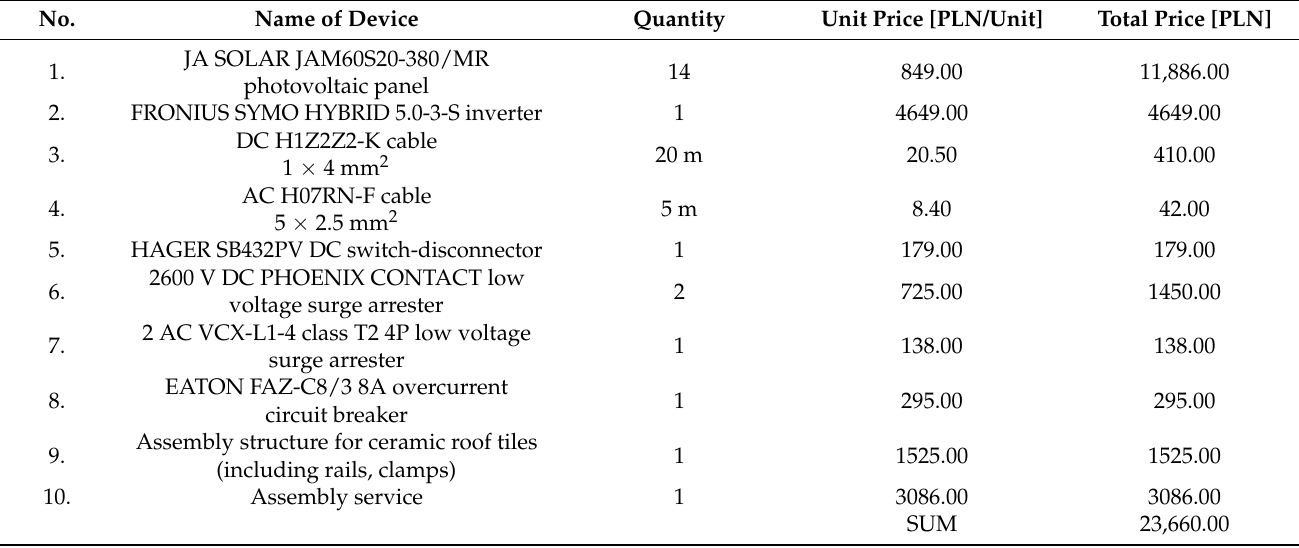
Table 1. Cost estimate for the designed photovoltaic system.